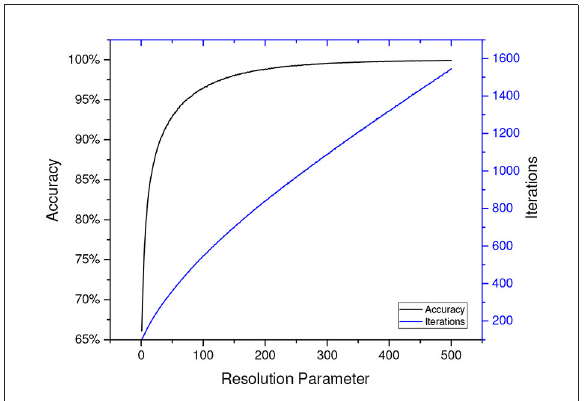
FIGURE1 The accuracy and iterations with different resolution parameters for DP ri (Oommen and Lanctôt, 1990) in benchmark environment E 1 , which is defined in Papadimitriou et al. (2004). The results are averaged over 250,000 replications.